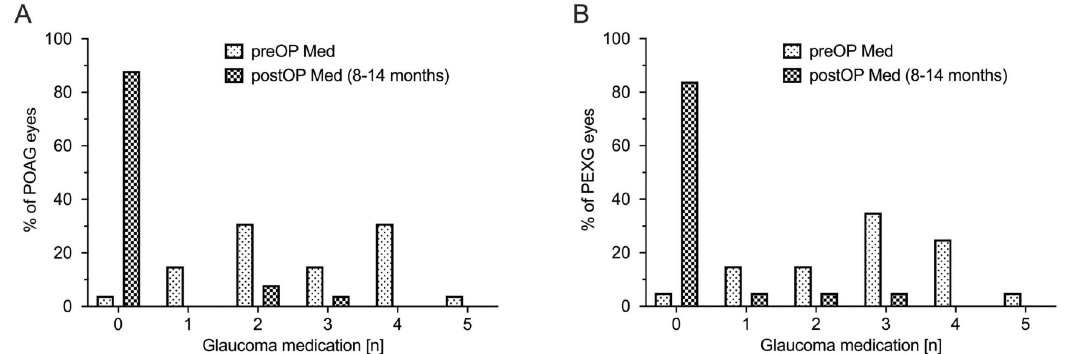
Fig 3. Number of antiglaucomatous medication. Number of antiglaucomatous medication preoperatively and one year postoperatively. (A) POAG = primary open angle glaucoma; (B) = PEXG = pseudoexfoliation glaucoma PreOP = preoperative intraocular pressure; postOP = postoperative intraocular